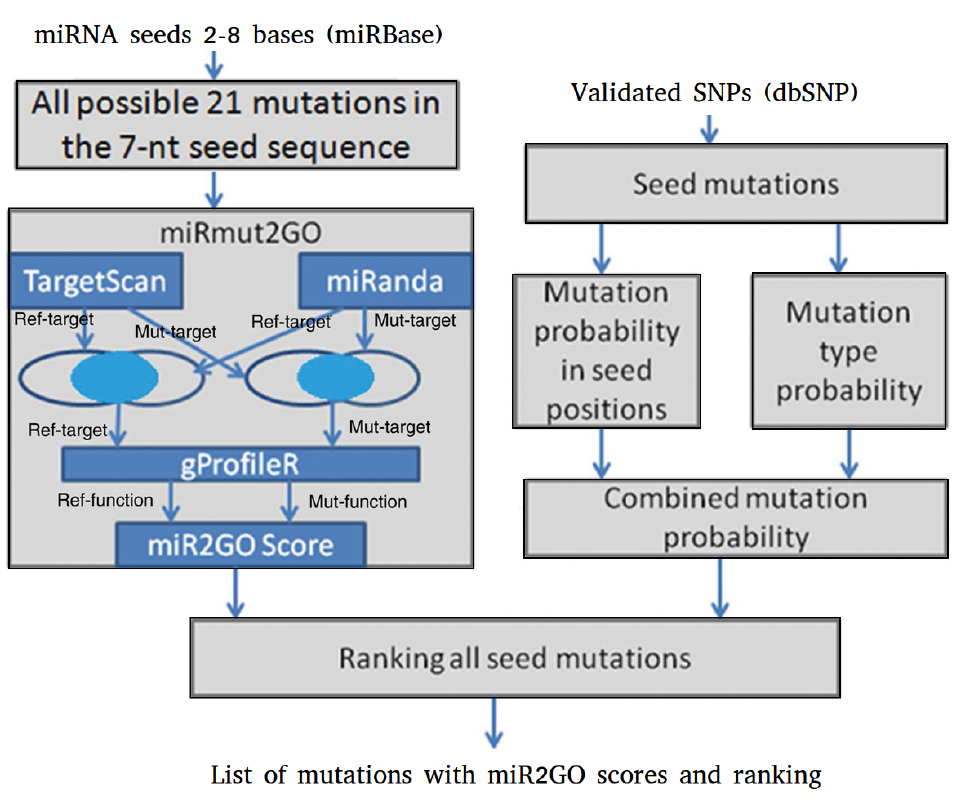
Figure 1: Workflow for assessing and ranking all possible seed mutations from miRmut2GO score and mutation probabil-